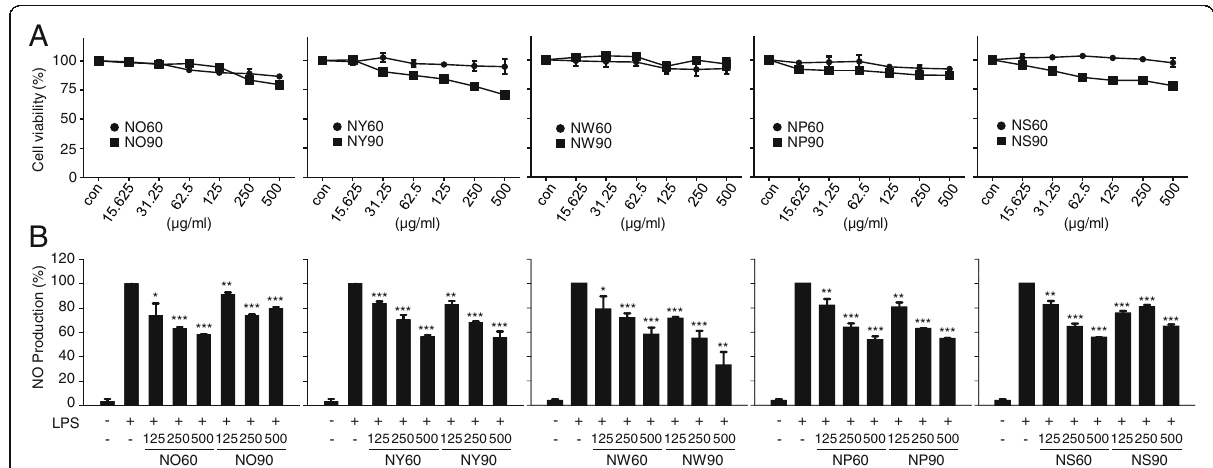
Fig. 1 Effects of Papaver nudicaule extracts on cytotoxicity and NO production. a RAW264.7 cells were treated with Papaver nudicaule extracts (15.625 – 500 μ g/ml) for 24h. Cell viability was measured by MTT assays. b RAW264.7 cells were treated with Papaver nudicaule extracts (125 – 500 μ g/ml) and LPS (100ng/ml) for 24h. NO production was examined in the culture supernatants. Data are presented as mean±SD from at least three independent experiments in triplicate. * P <0.05, ** P <0.01 and *** P <0.001 indicate statistically significant differences compared with the group treated with LPS